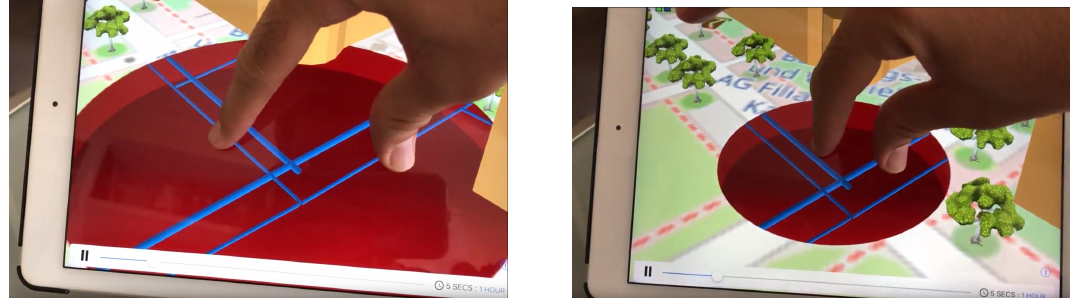
Figure 19. Multitouch composition of ground hole, to enable the interactive inspection of underground